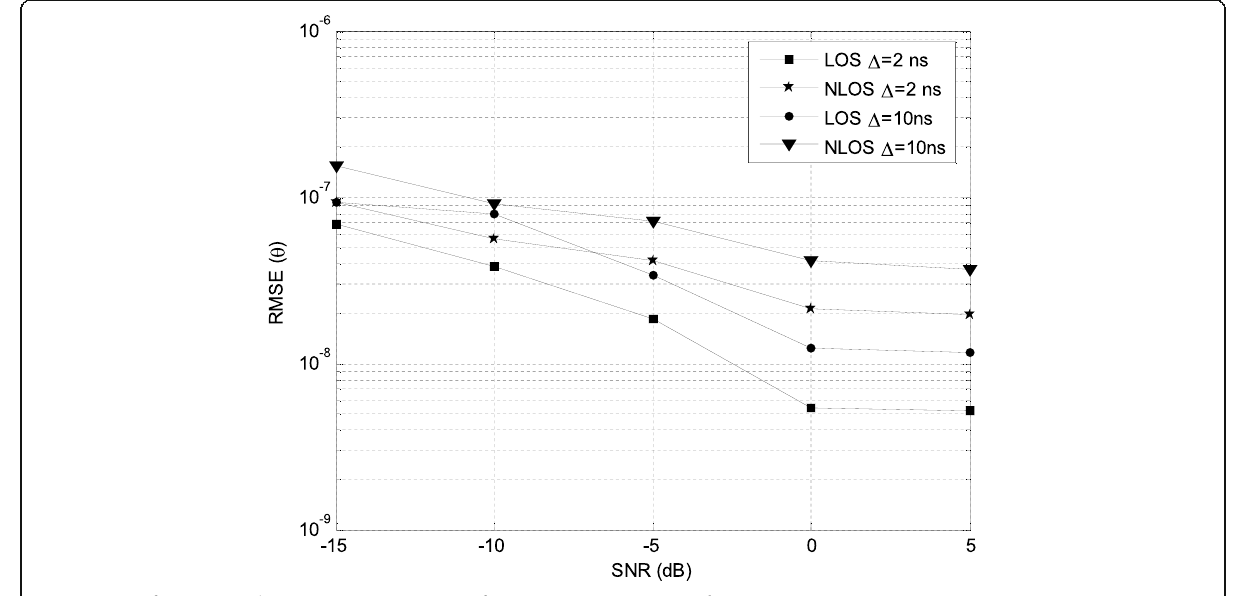
Fig. 6 RMSE of TD energy detection estimator vs. SNR, for various integrating step